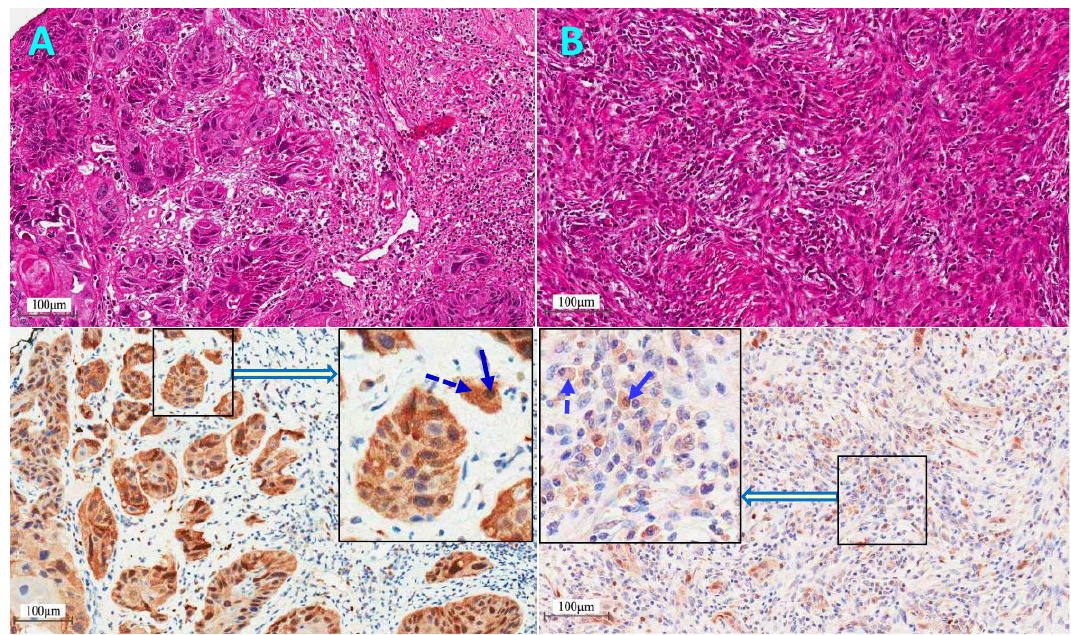
Figure 5. Examples of pathological tissue sections of head and neck squamous cell carcinomas stained with hematoxylin and eosin ( upper panels ) and the corresponding immunohistochemical staining for p16Ink4a ( lower panels ) showing nuclear (solid arrows) and cytoplasmic staining (dashed arrows). Sample ( A ) shows strong staining (usually involving >70% of the tumor cells) scored as p16-positive as compared to sample ( B ) with weak patchy staining, arbitrated as p16-negative.